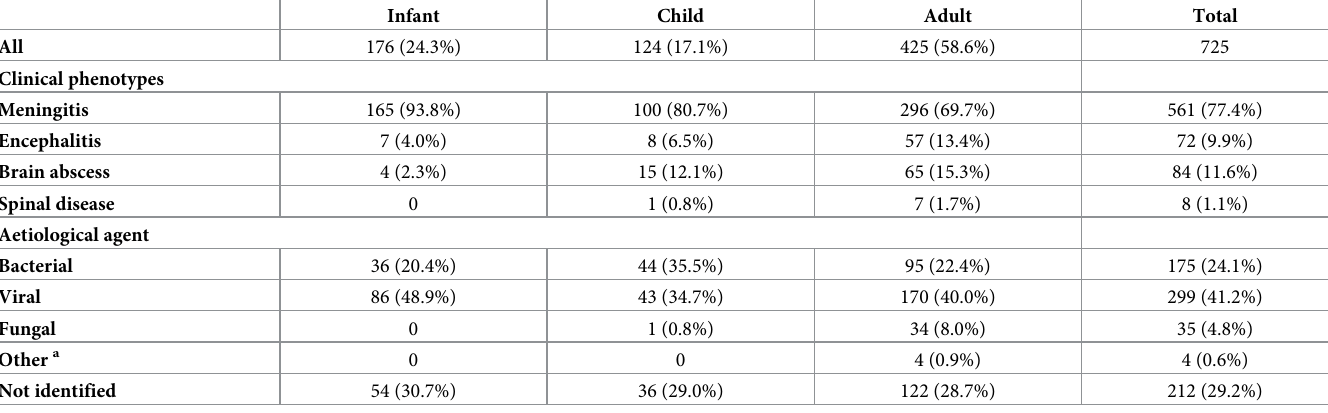
Table 1. The number of cases of CNS infection in infants, children and adults stratified by clinical phenotype and aetiology.